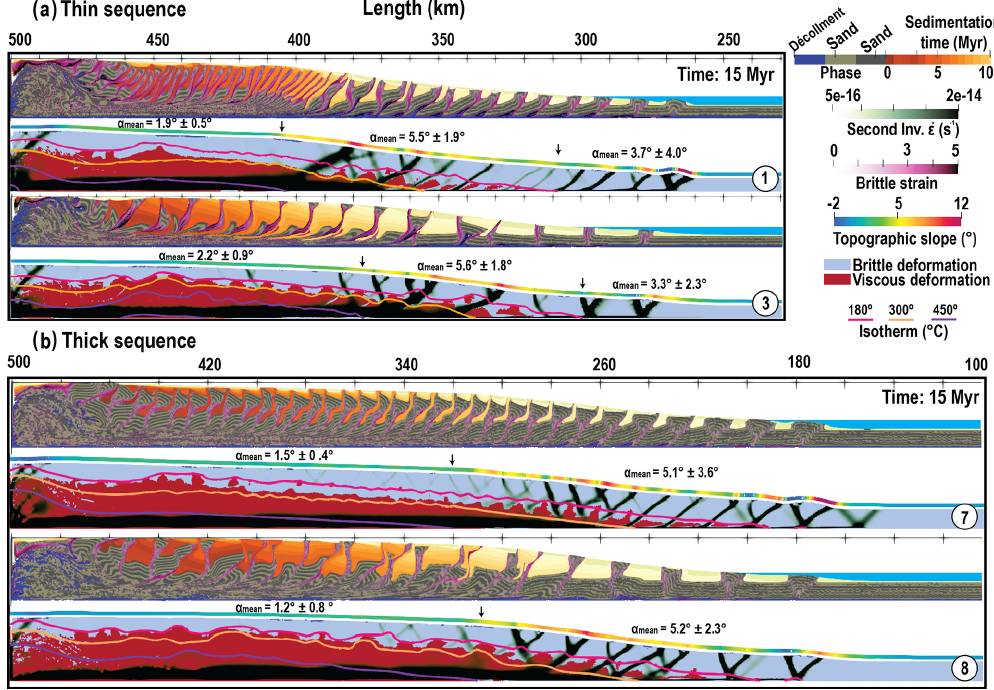
Figure 4. Models with shear heating on after 15Myr of shortening. (a) Thin and (b) thick sequence pile models. M1 , M3 and M7 , M8 are the same experiment with normal and high surface diffusion rates, respectively. Experiment parameters are given in Tables 1 and 2, and color code for markers is given in Fig. 2, 1:1